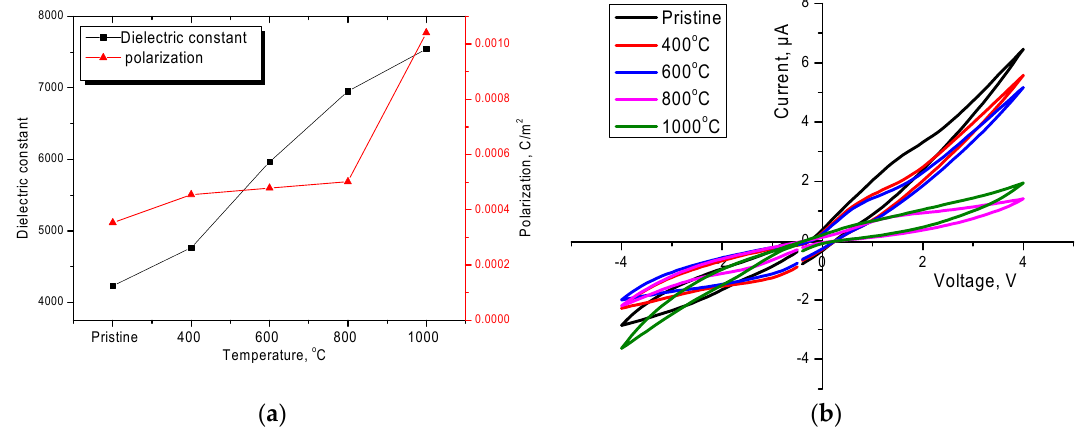
Figure 7. ( a ) Graph of the change in the dielectric constant maximum and spontaneous polarization; ( b ) graphs of cyclic volt-ampere characteristics of ceramics.